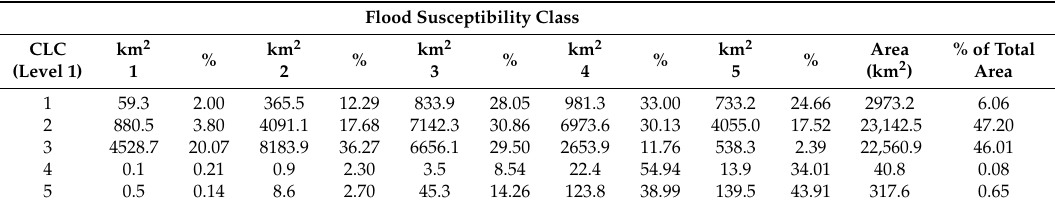
Table 6. Area coverage of land cover classes corresponding to the defined flood susceptibility classes. CLC: CORINE land